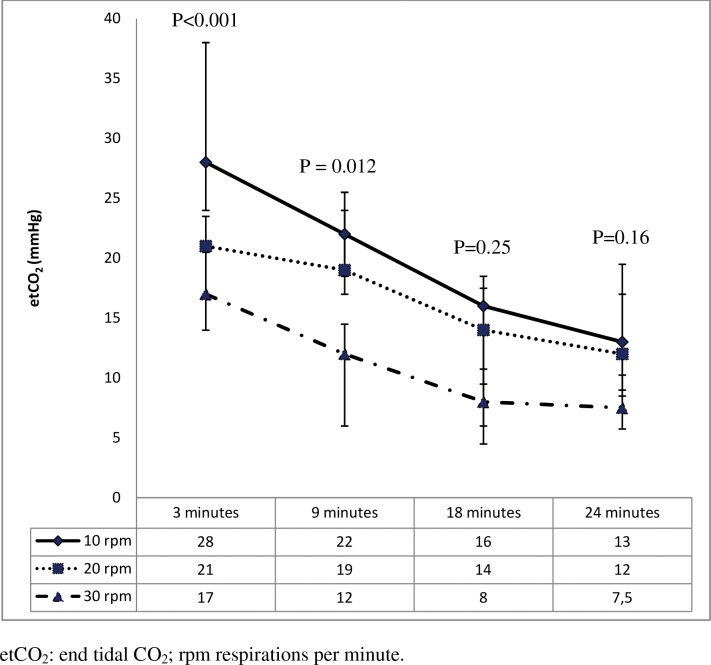
End-tidal CO2 values during resuscitation.